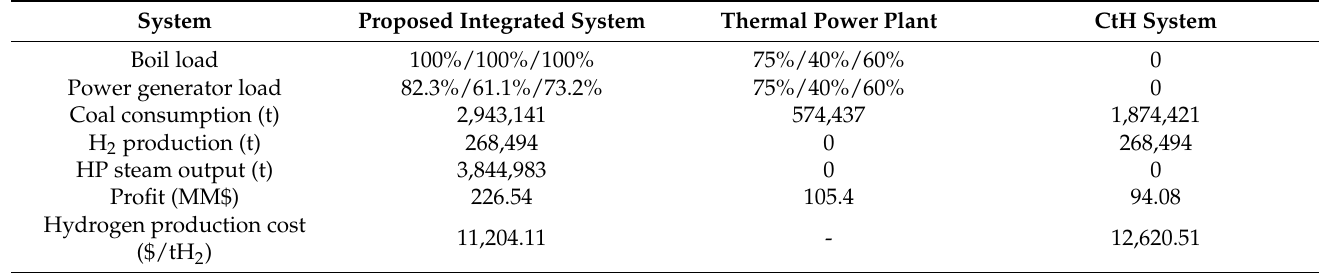
Table 6. Comparison between the proposed integration system and independent